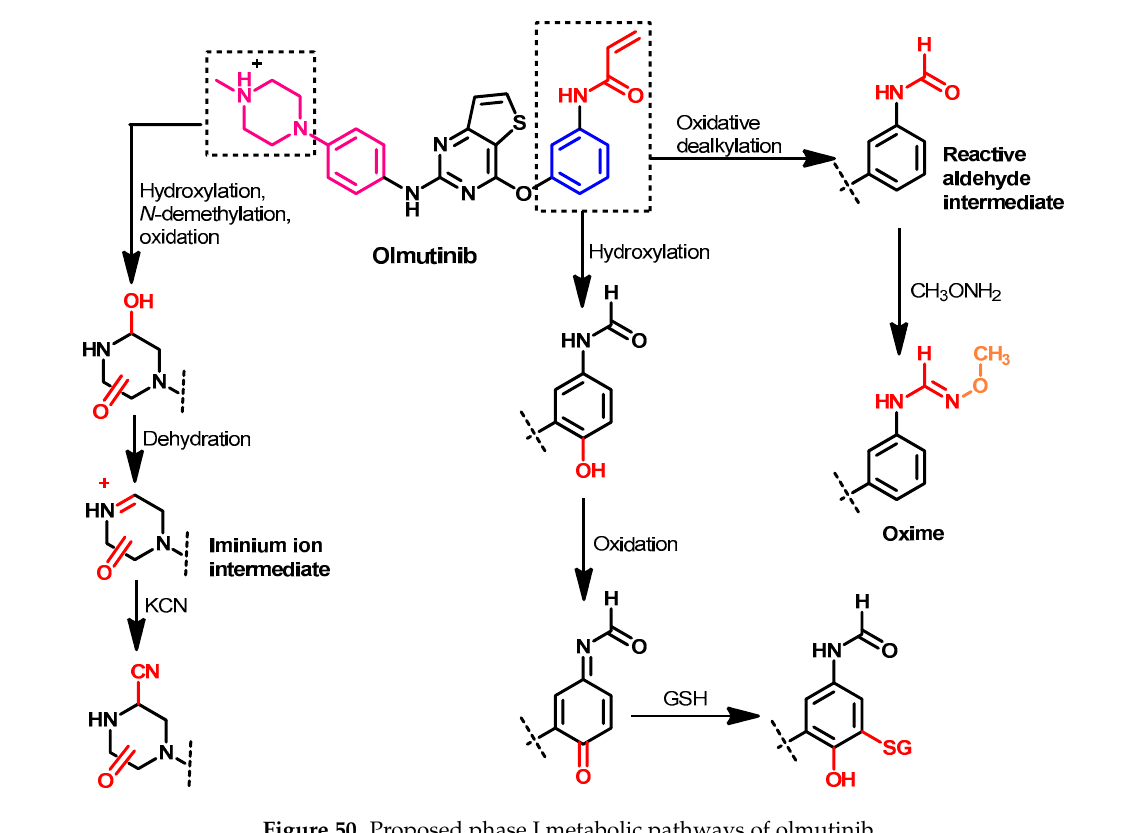
Figure 50. Proposed phase I metabolic pathways of olmutinib.